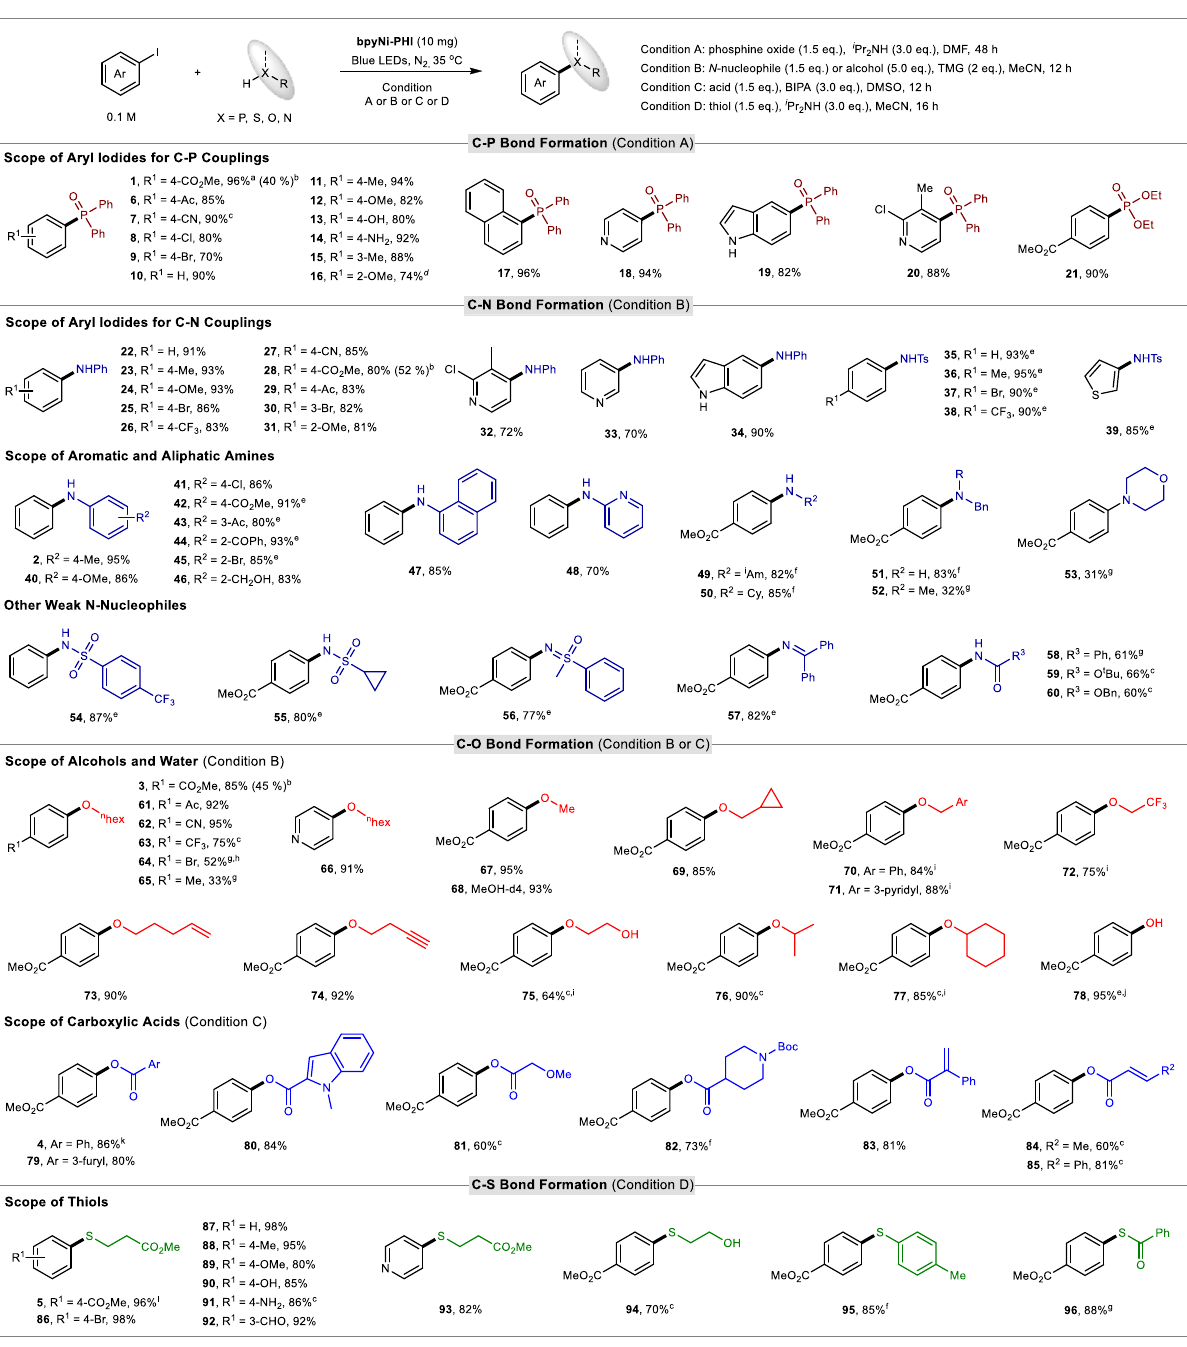
(0.6mmol, 3.0 eq.) in MeCN (2mL). a 42 h. b Using methyl 4-bromobenzoate as coupling partner. c 24 h. d 60 h. e 16 h. f 36 h. g 48 h. h 13/1 ratio of